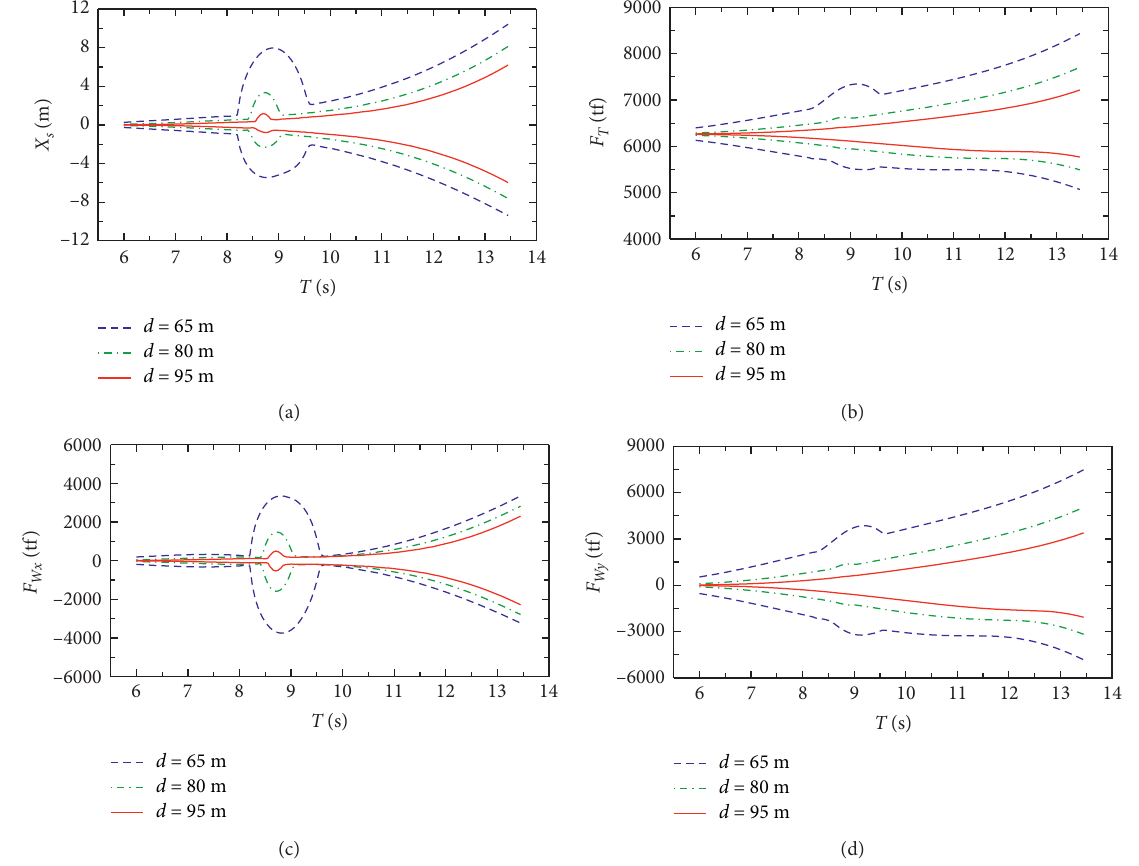
Figure 11: Relevant physical quantities are changed by various wave periods T with different water depths (d): (a) the horizontal displacement of the tube X s , (b) the mooring cable tension F T , (c) the horizontal wave forces F F Wy ( s � 0.04; BWR �